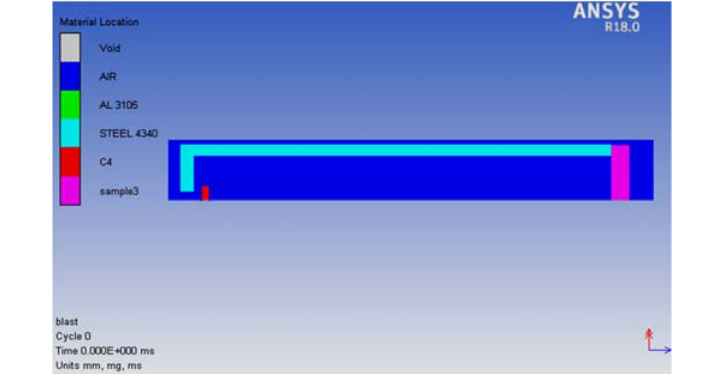
Figure 16: Two-dimensional geometry.